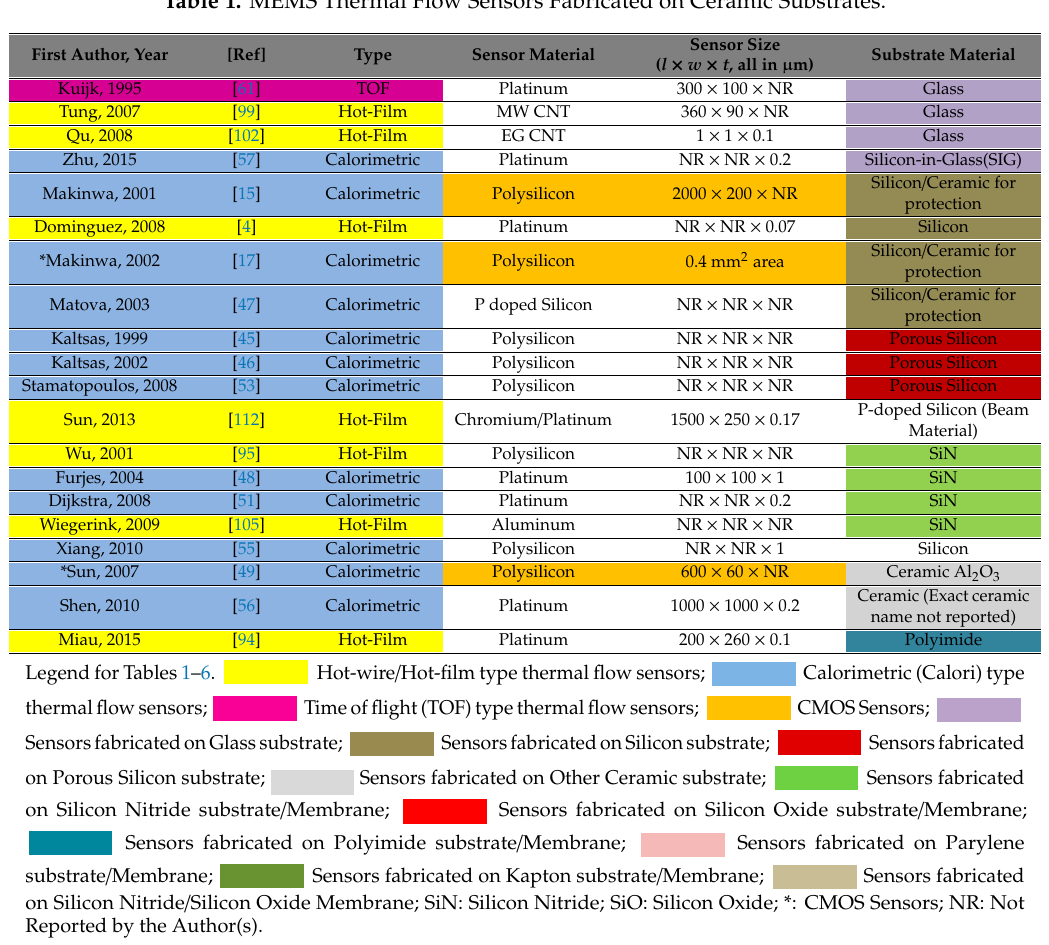
Table 1. MEMS Thermal Flow Sensors Fabricated on Ceramic Substrates.